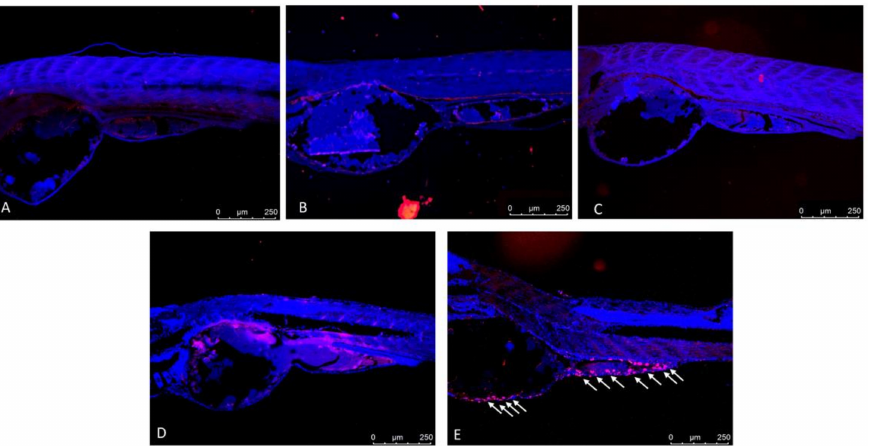
Figure 6. TUNEL assays indicated an abnormal apoptotic pattern. TUNEL-positive apoptotic cells (white arrow) in zebrafish embryos treated with IVM and CYP at 96 hpf. CTRL ( A ), acetone ( B ), IVM ( C ), CYP ( D ), and IVM + CYP ( E ).